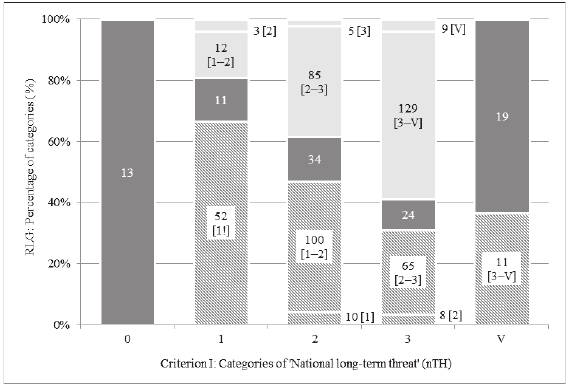
Figure 4. Spread of RLG-values (y-axis) by applying the matrix algorithm (Table 3). The analysis is based on nTH (criterion I, x-axis) for habitat types in Germany. Full dark pigmented bar = no change in cat- egory; full light-coloured bar = downgrading of threat category value; brindled bar = upgrading of threat category value; Labels: number of attributive habitat-types in the [resulting